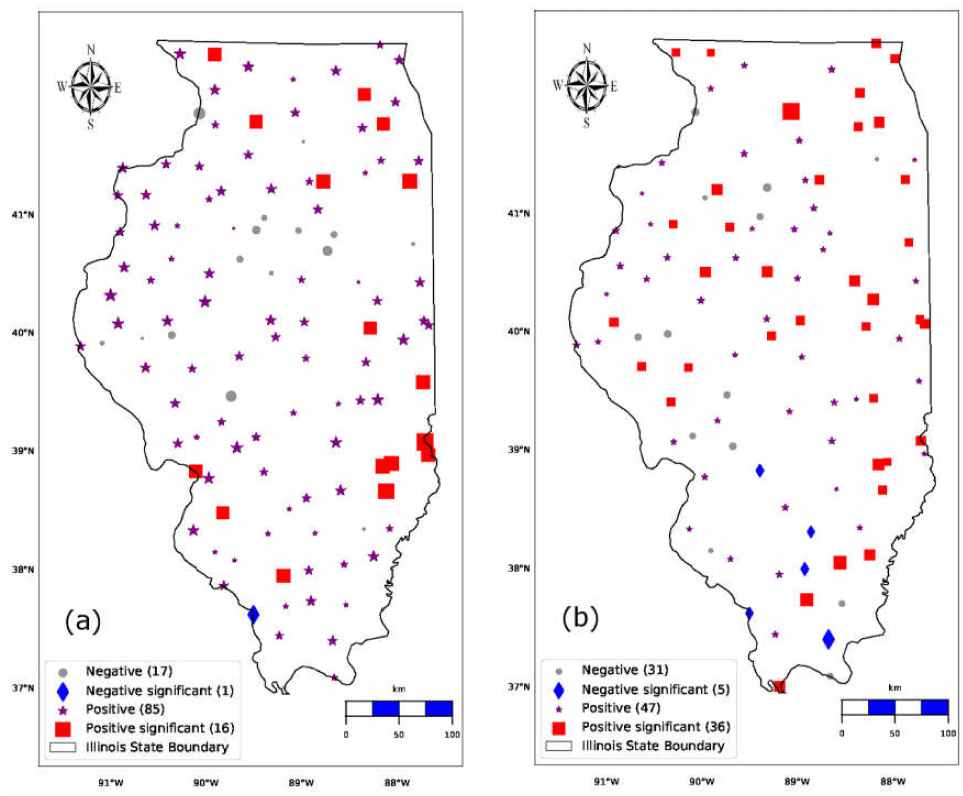
Figure 4. Distribution of trends in the precipitation parameters during the cropping season: ( a ) cumulative rainfall and ( b ) number of rainy days. In all the figures, the marker sizes have been scaled to represent the magnitude of the Theil–Sen